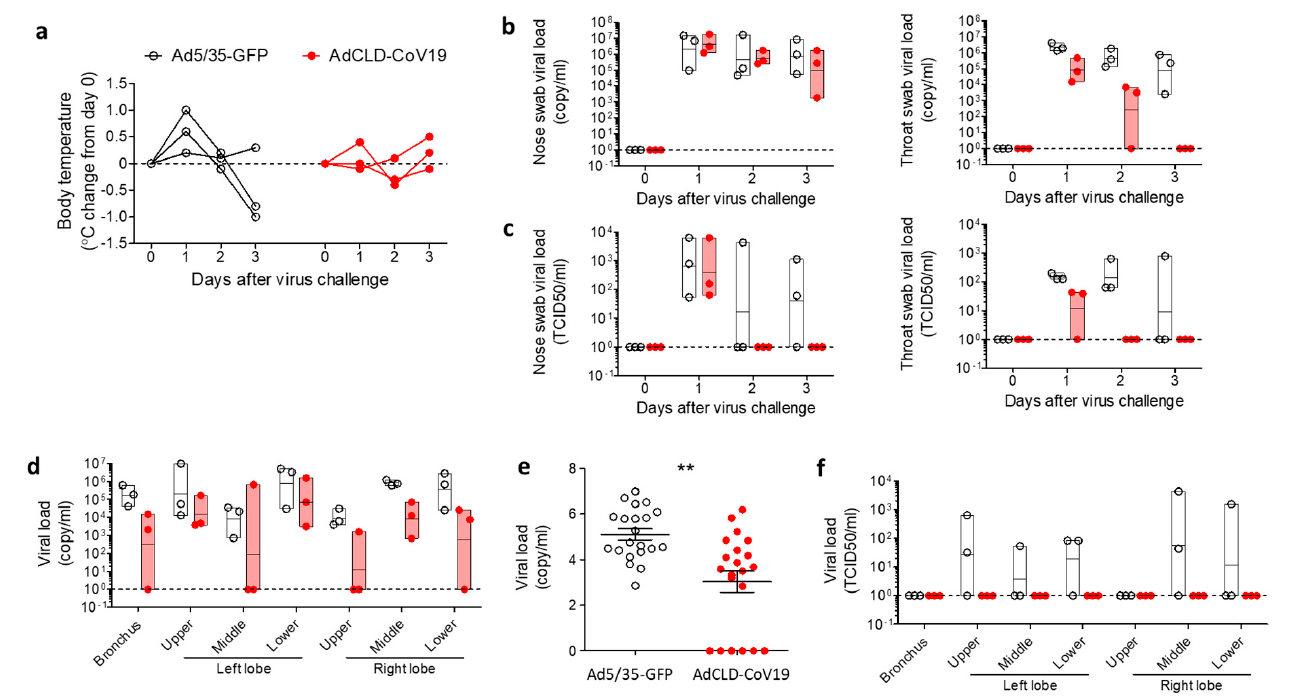
Figure 4. Protective efficacy of AdCLD-CoV19 against SARS-CoV-2 challenge. AdCLD-CoV19 vaccinated cynomolgus macaques and control vector (Ad5/35-GFP) administered macaques were challenged with SARS-CoV-2 at 7 weeks post-vaccination. ( a ) Body temperature changes in macaques after the challenge are shown in a graph. ( b ) Viral RNA from the nose (left) and throat (right) swab samples of macaques at the indicated time points were measured by qRT-PCR. ( c ) Infectious viral loads of the nose (left) and throat (right) swab samples were measured using the TCID50 assay. ( d ) Lung tissues were collected from macaques on day 3 post-challenge and quantified for viral RNA using qRT-PCR. ( e ) The pooled data of all examined lung tissues are shown as a graph. ( f ) Infectious viral loads in lung tissues were measured using the TCID 50 assay. Two-tailed Student’s t -test was used for the analysis. **, p < 0.01.